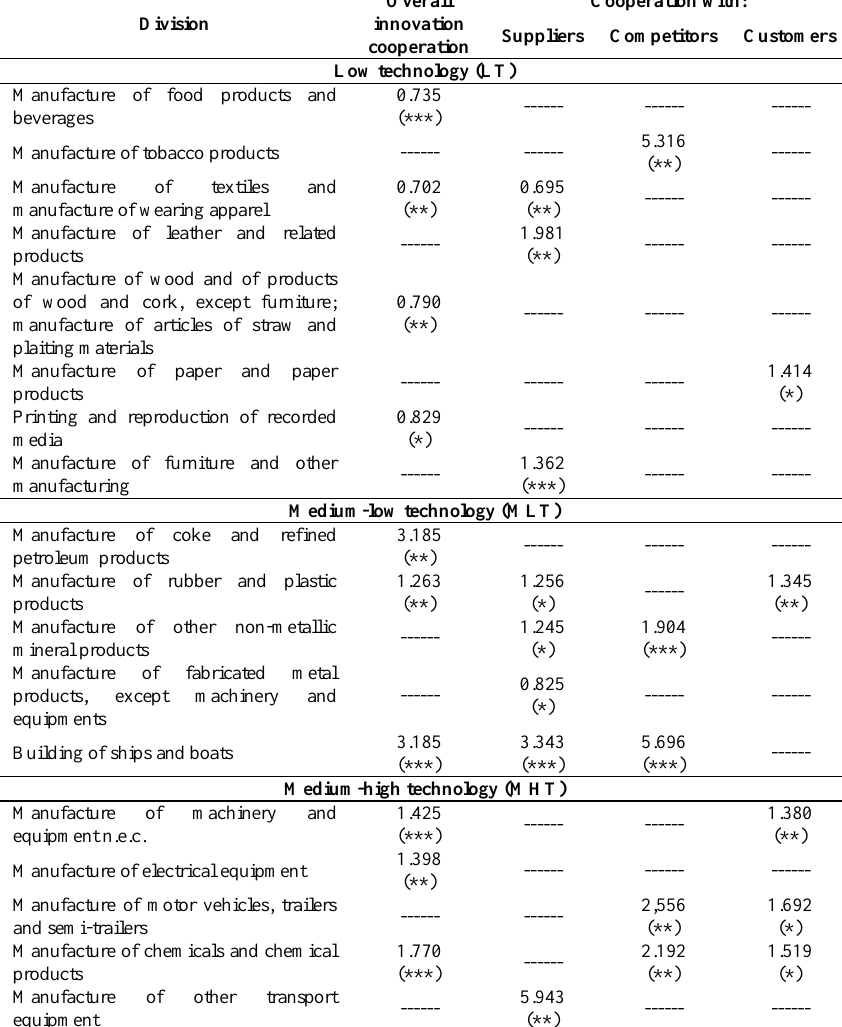
Table 1. Odds ratios in multiple logit regression portraying the impact of industrial structure on innovation cooperation, including suppliers, competitors, customers Overall Division